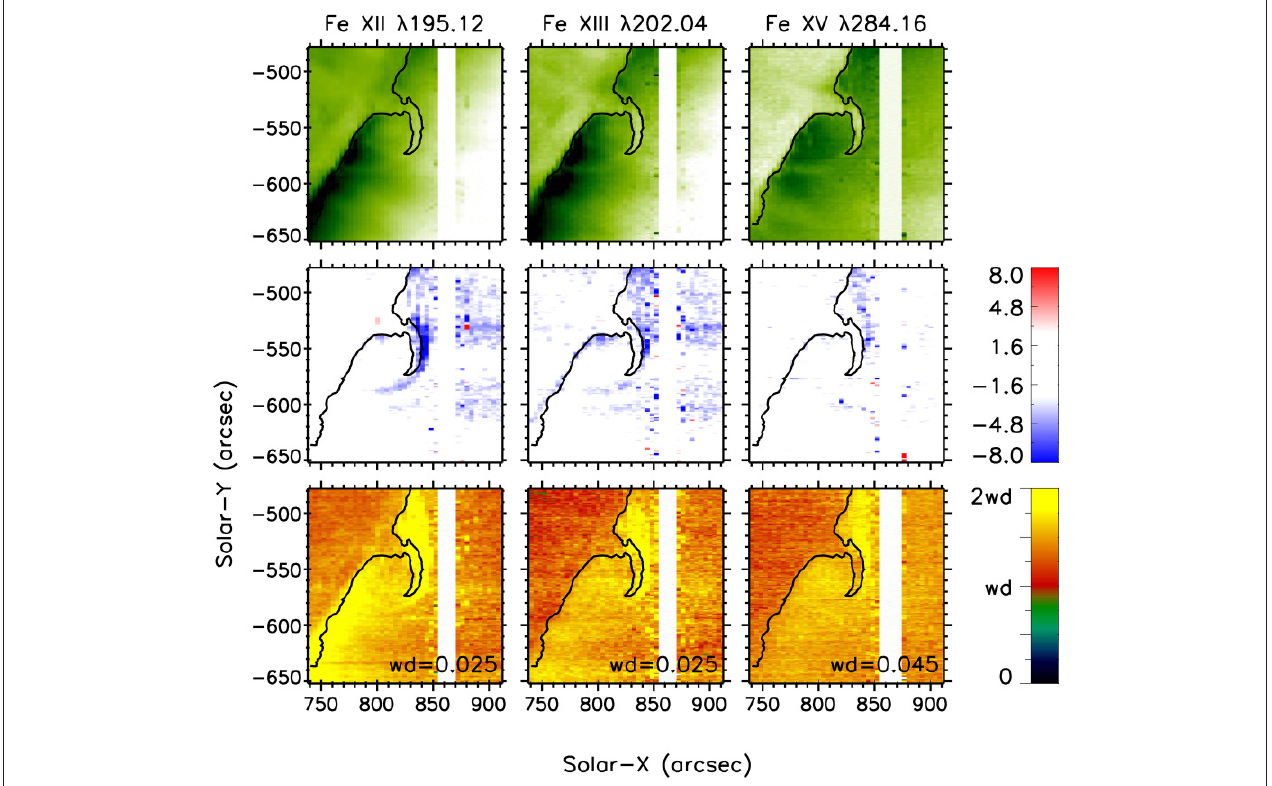
FIGURE 4 | A subfield of the EIS raster scan starting from the left at 19:22 UT and finishing at 20:27 UT. Top row : EIS intensity (inverse log) for Fe XII 195.12 Å, Fe XIII 202.04 Å, and Fe XV 284.16 Å. Middle row : Doppler velocity maps for the three lines. Bottom row : Line widths of the given lines with the median line width (wd) given in each window. The white stripes are regions of missing